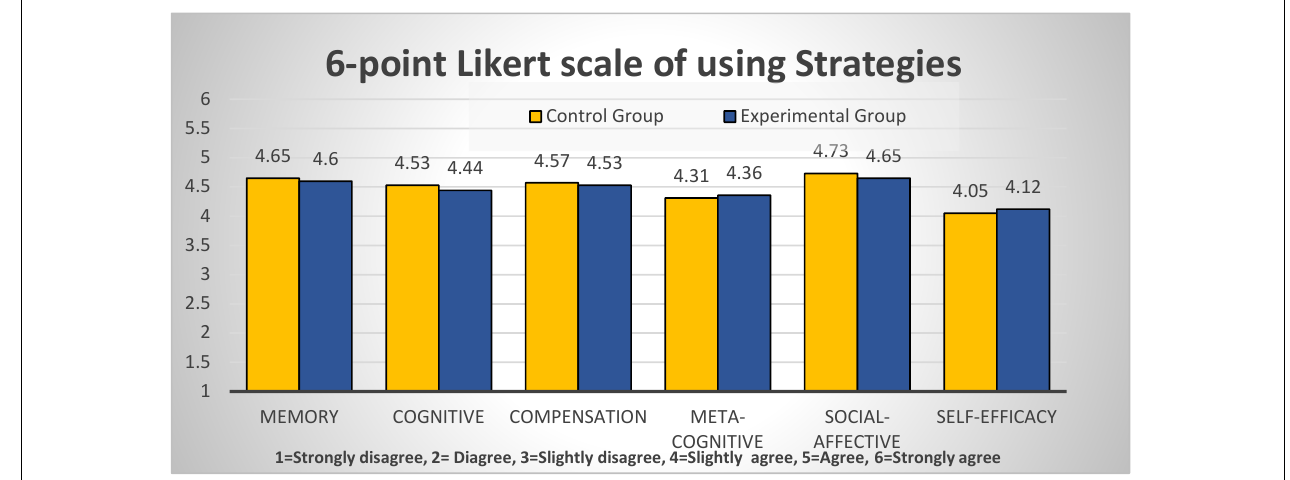
FIGURE 6 | Comparison of means of reported listening strategies from the two